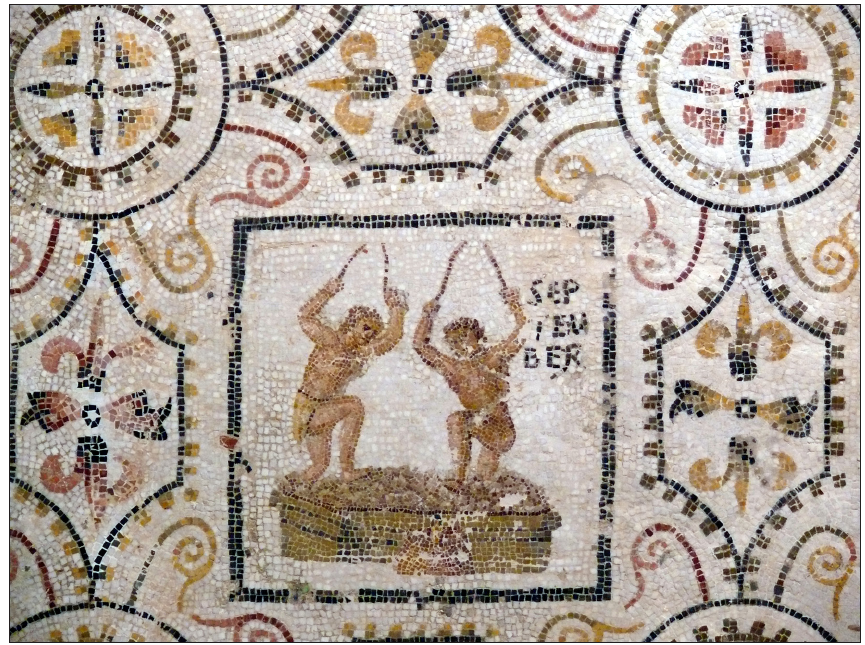
Figure 4: Portion of the Mosaic of the Months, El Djem (Sousse Museum), September. (Photo: Ad Meskens, licensed under Creative Commons Attribution-Share Alike 3.0 Unported